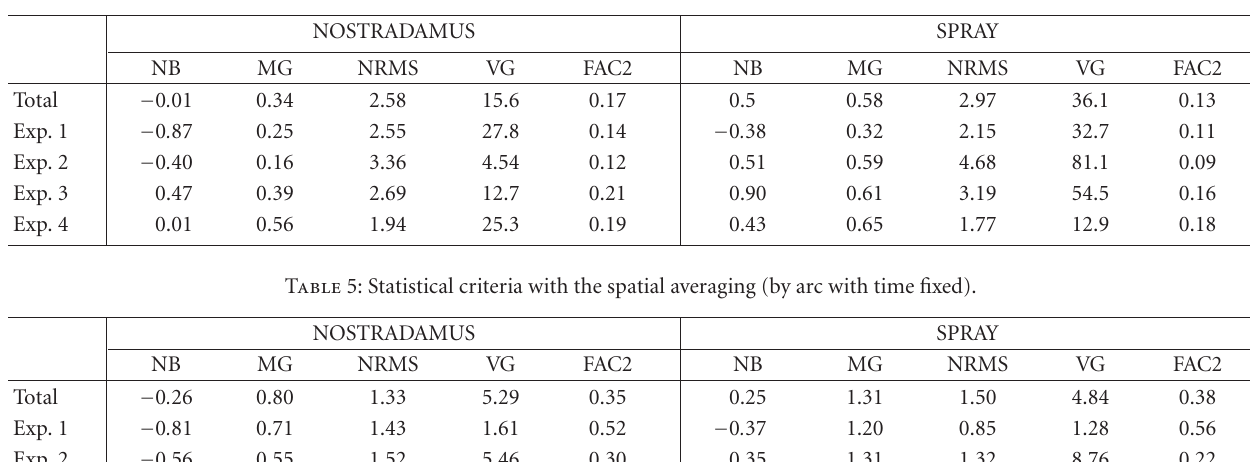
Table 4: Statistical criteria pairing in time and space.